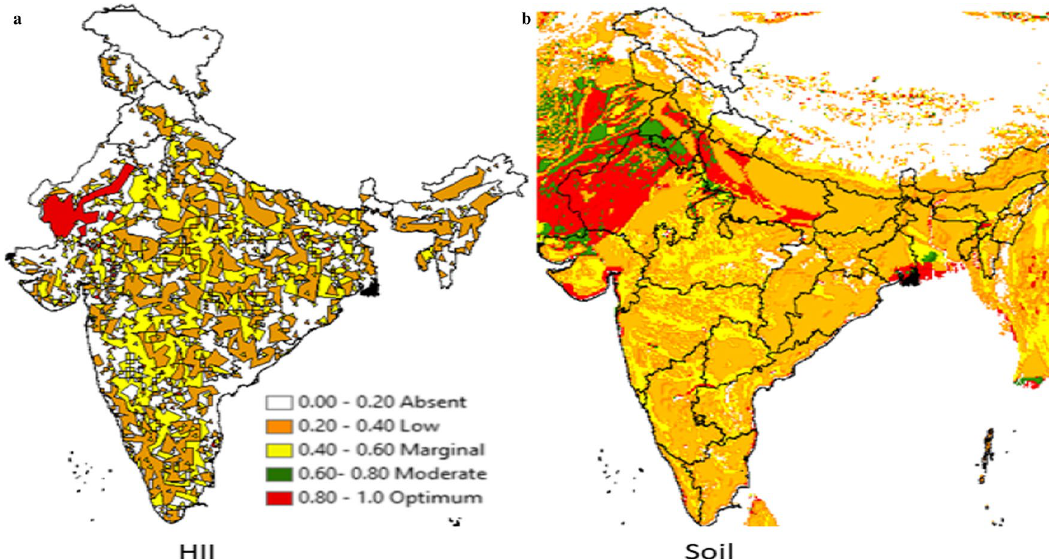
Fig. 15 Projected habitat suitability classes of C. wightii in India with non-bioclimatic variables HHI ( a ) and soil ( b